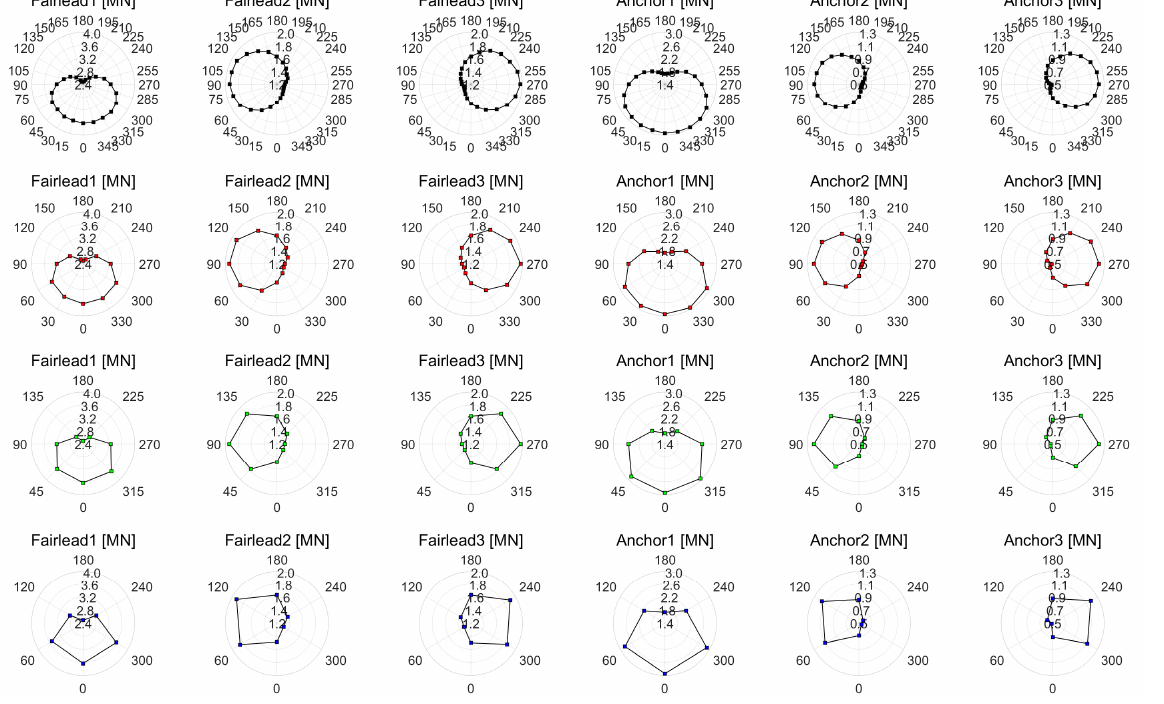
Figure 17. Normalized values for maximum platform’s motion according to the interval angles. Figure 18. Normalized values for maximum blade and tower’s moments according to the interval angles.